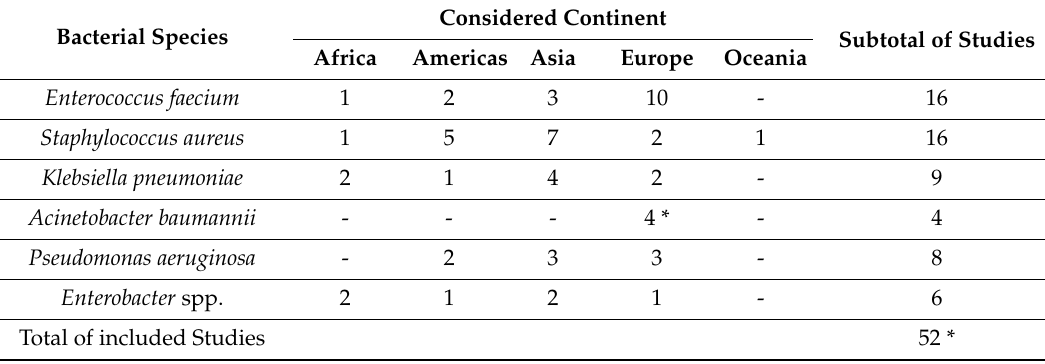
Subtotal of Studies